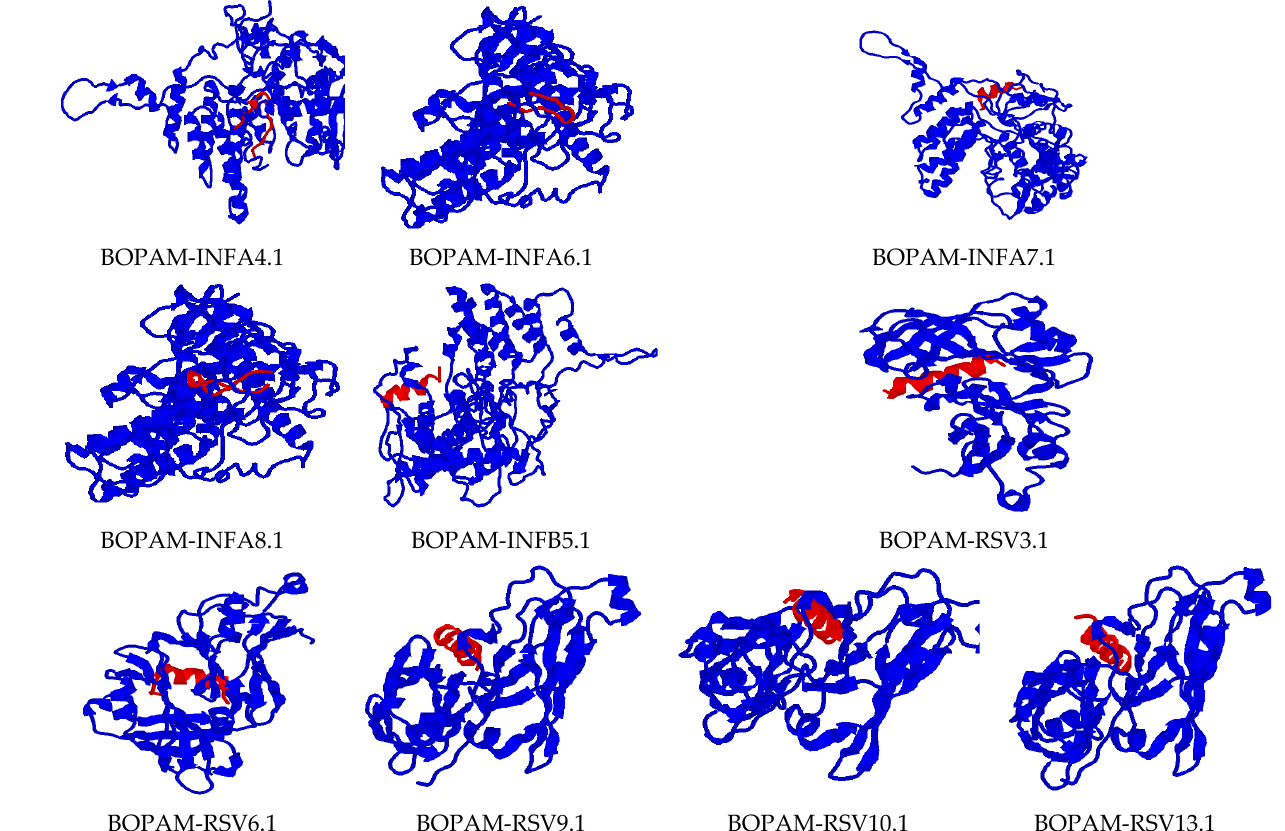
Figure 4. Docking interaction analysis of the mutated Ap-AMPs with their respective receptors using PATCHDOCH, visualized using PyMOL. The blue color represents the receptors, while the red color represents the AMPs.